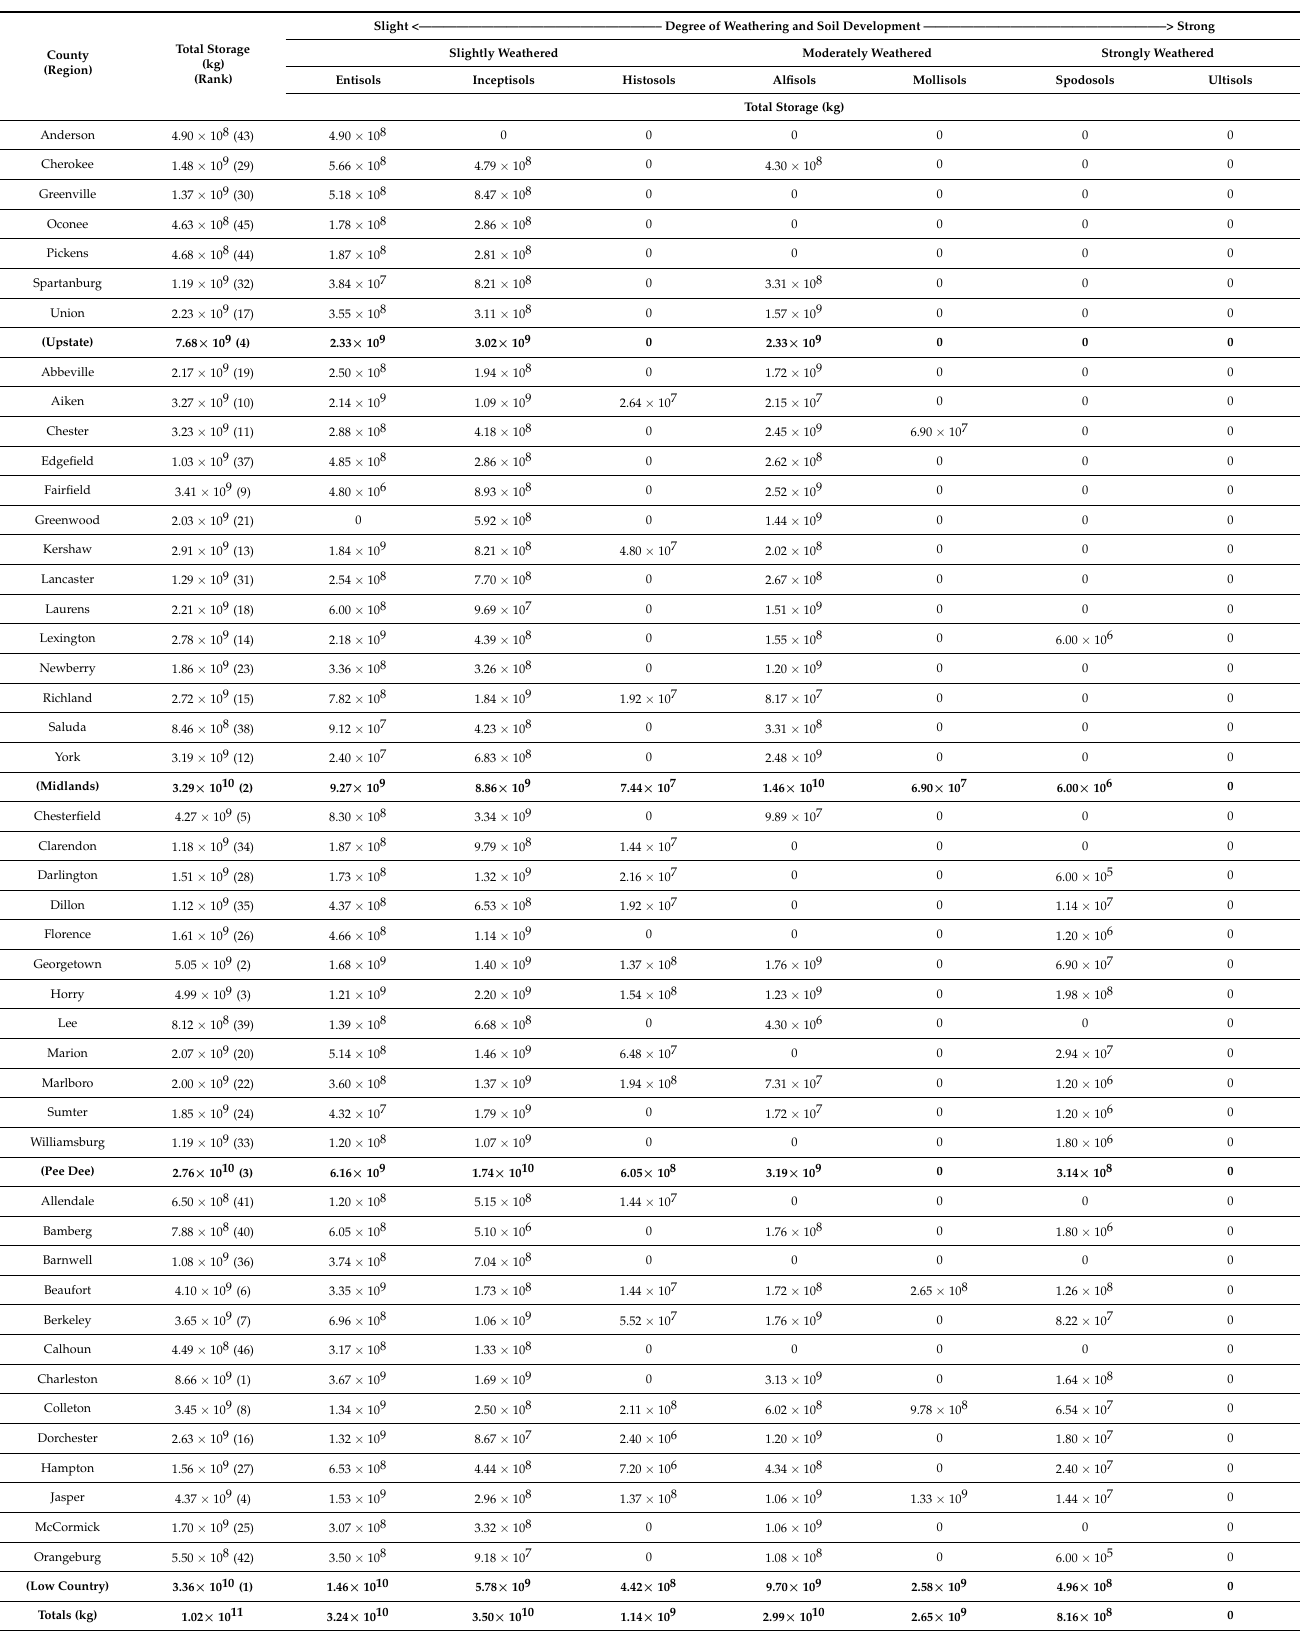
Table 7. Mid-point total soil inorganic carbon (SIC) storage by county, region, and soil order for the state of South Carolina (U.S.A.), based on mid-point soil inorganic carbon (SIC) contents in the upper 2 m based on data from Guo et al., 2006 [18]. Slight<———————————————————–DegreeofWeatheringandSoilDevelopment———————————————————–>Strong TotalStorage SlightlyWeathered ModeratelyWeathered StronglyWeathered County (kg) (Region) (Rank) Entisols Inceptisols Histosols Alfisols Mollisols Spodosols Ultisols TotalStorage(kg)